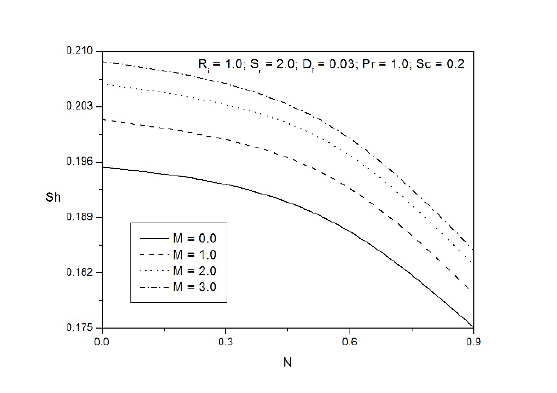
Figure 9. Effect of Magnetic parameter M on Mass Transfer Rate